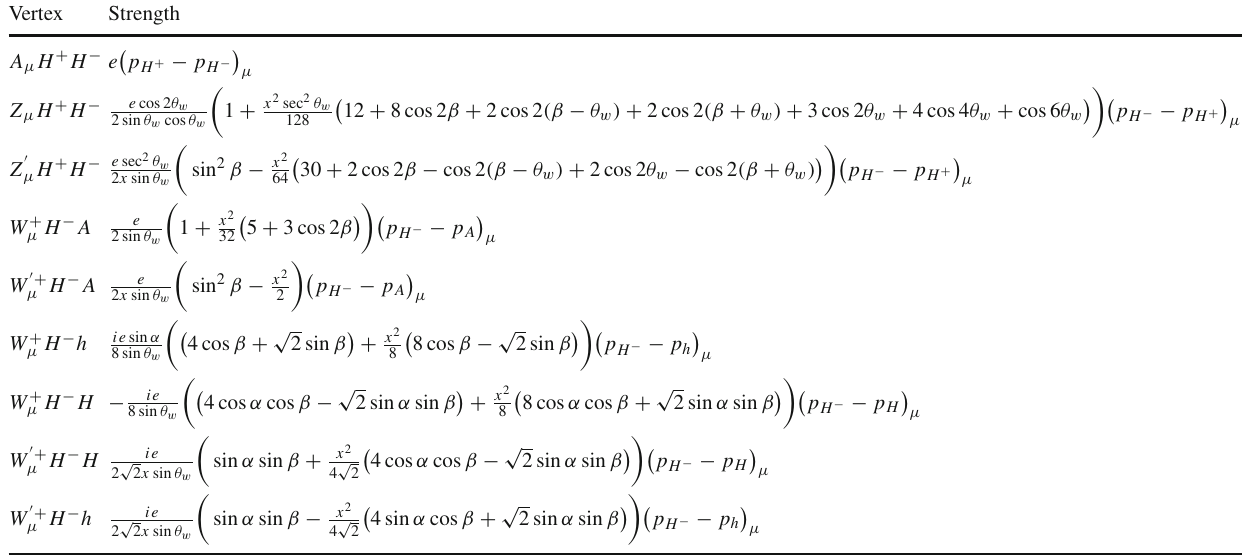
Table 3 All the triple point V X X couplings in the models where V is a (light or heavy) gauge boson and X is a scalar. These have been computed to O ( x 2 ) Vertex